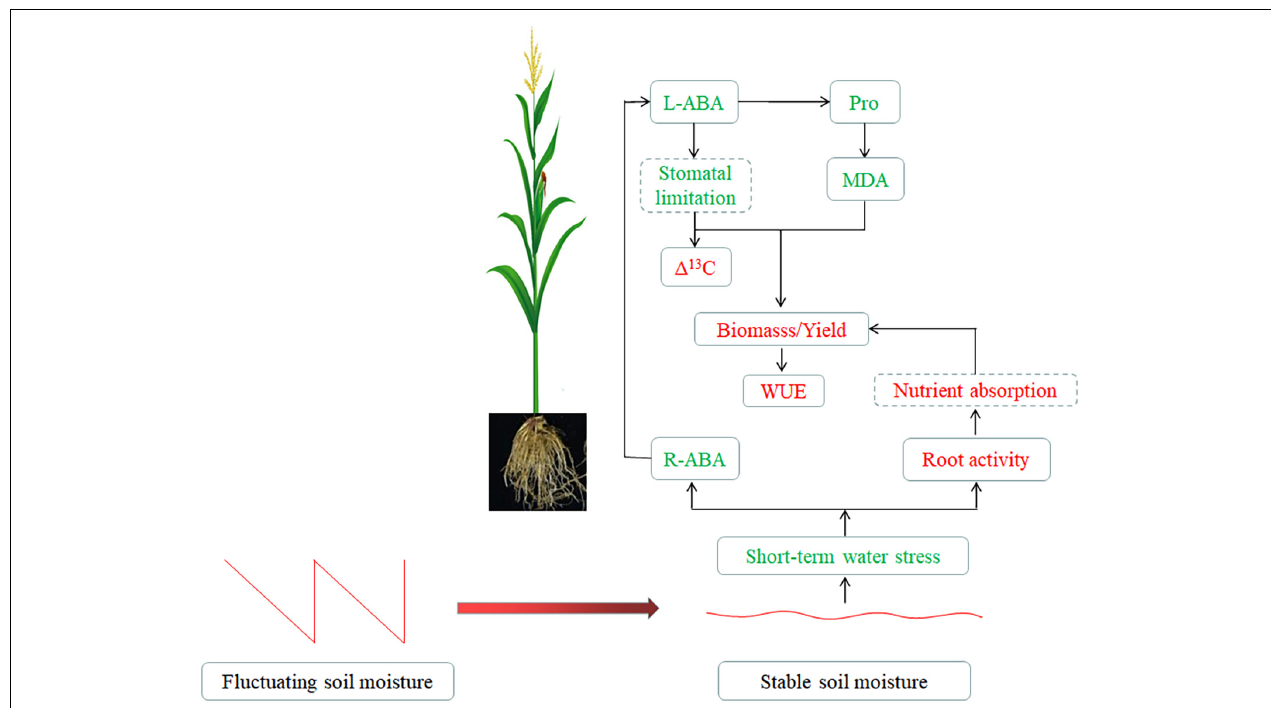
FIGURE 7 | Physiological changes in maize under stable soil moisture. The green font represents the decreased indices or weakened physiological process, and the red font represents the increased index or enhanced physiological process under SSM conditions. The dotted box represents the index or physiological process not measured in this